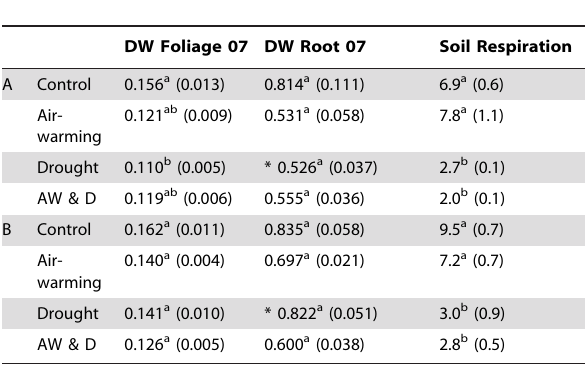
Table 1. Effects of climate treatments and soil types on soil respiration, foliage biomass and coarse root